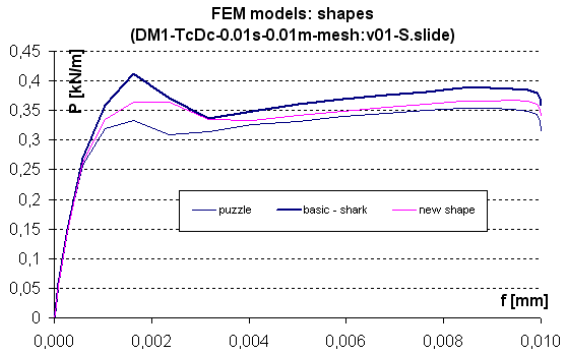
Figure 23: Results of 1D1 models (PZ, SA, and SN shapes) for particular specifications of the FE model: force–displacement curve, material curve for concrete TcCd according to Fig. 14 and isotropic hardening for steel [1]; time of 1 s for the explicit procedure [1] and approximately 0.01 m size of the finite elements (solid elements, reduced integration)